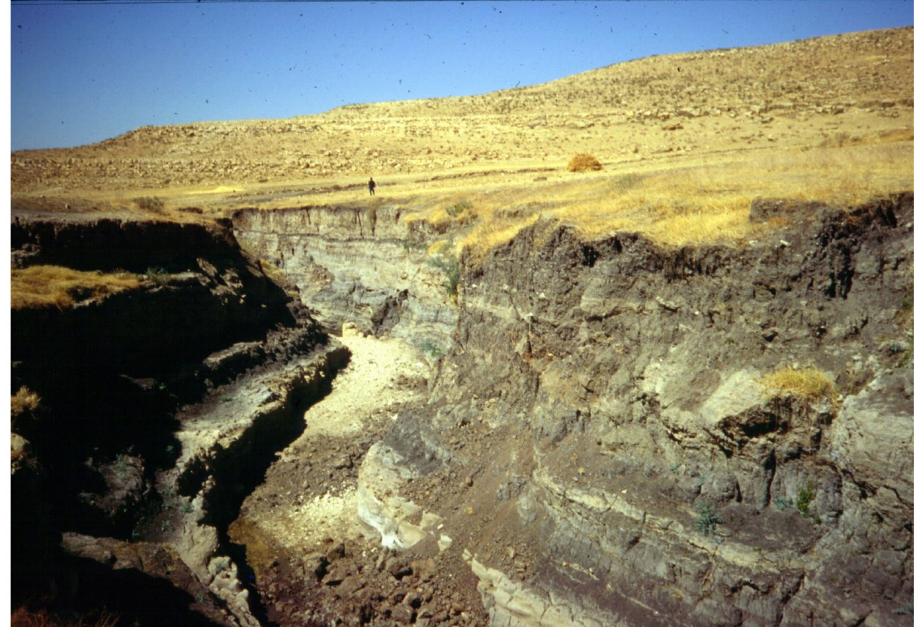
Figure 5. The backfill deposits of the May Makden tufa dam: a complex sequence of stromatolithic tufa levels, lacustrine clay, peat, alluvial gravels, and buried soils testifying repeated aggrada- tion/erosion